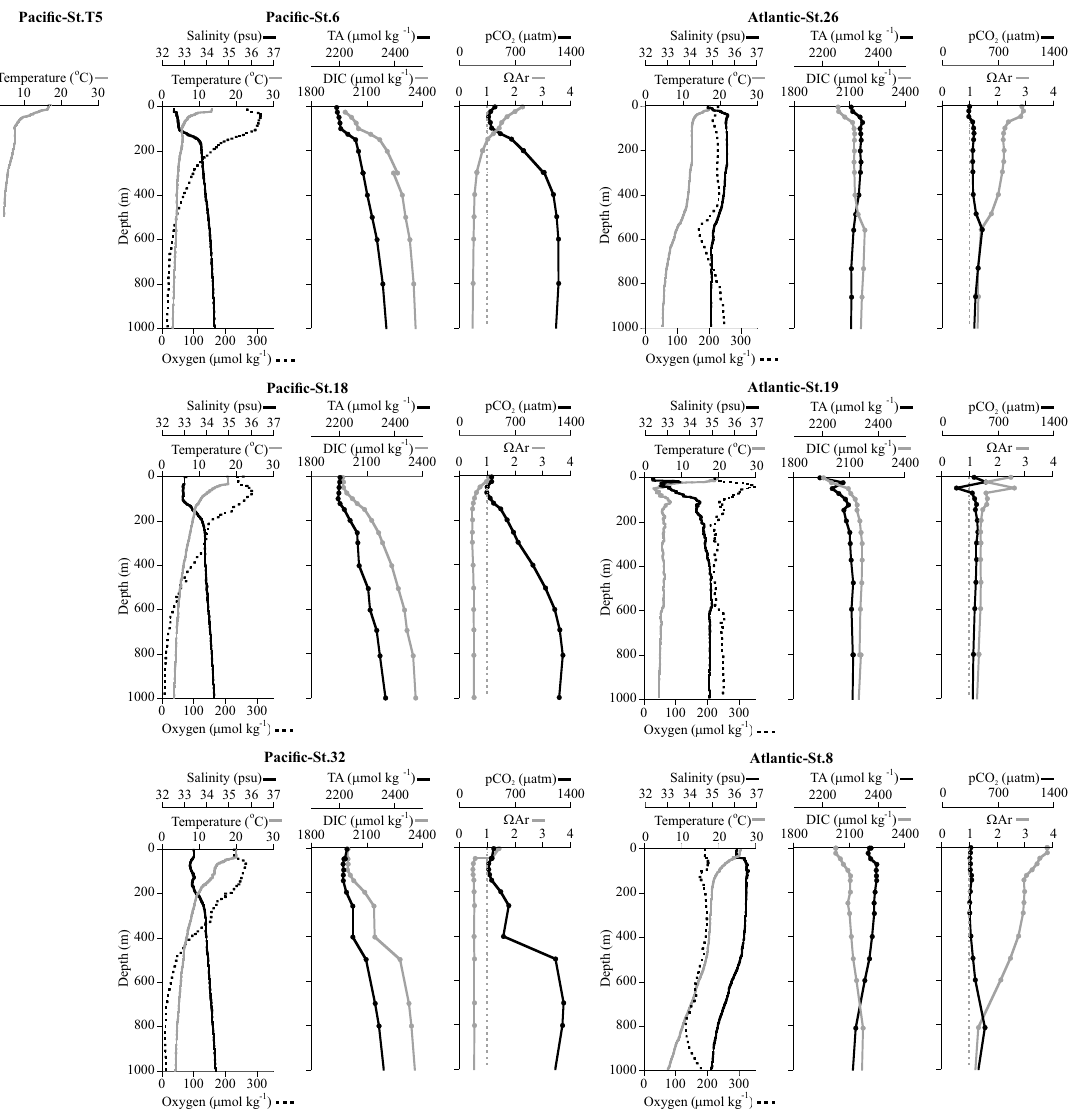
Figure 2. Hydrography of sampling regions. Hydrographic profiles of stations representative of the specific water mass types from the northern (P-T5, P-6, A-26), middle (P-18, A-19), and southern (P-32, A-8) portions of the Pacific (P) and Atlantic (A) study transects (station locations: Fig. 1). At station P-T5, the temperature profile (grey) was from an XBT cast because no CTDs were conducted during transits. For all stations along the main transects, left-hand plots show temperature (grey), salinity (black), and oxygen (black dotted) measured via sensors on the CTD and binned to 1m depth intervals. Middle plots show TA (black) and DIC (grey) from discrete bottle samples (dots show depths of bottle samples). Right-hand plots show p CO 2 (black) and aragonite saturation state ( (cid:127) Ar ; grey) calculated based on TA and DIC